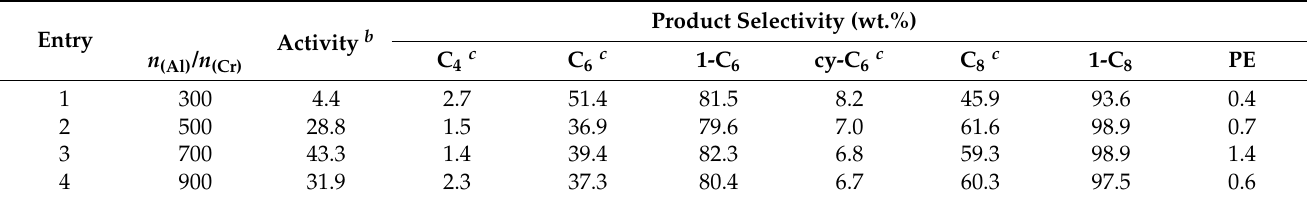
Table 4. Evaluation of the effect of Al/Cr molar ratios on the catalytic performance of the L4-based catalyst a .